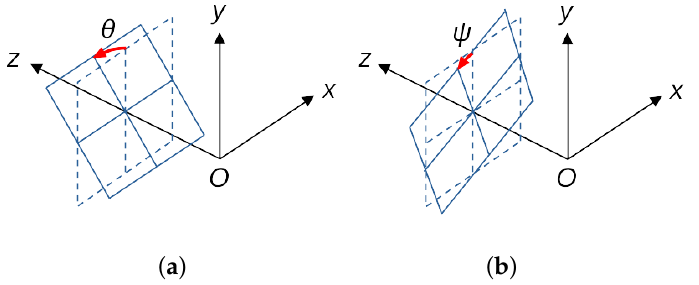
Figure 2. ( a ) Inclination of the object surface due to rotation around x-axis. The direction of the rotation axis is also one of the degrees of freedom. ( b ) In-plane